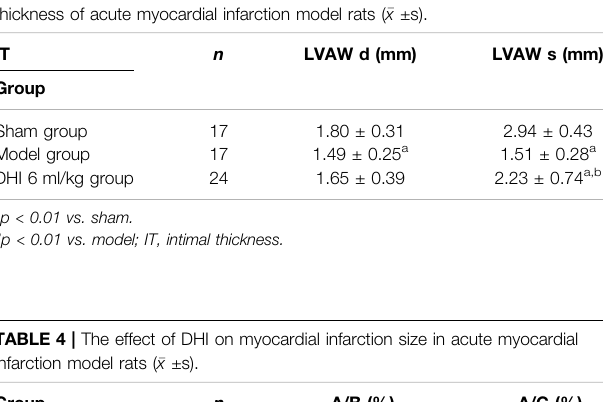
TABLE 4 | The effect of DHI on myocardial infarction size in acute myocardial infarction model rats ( (cid:1) x ±s). Group n A/B (%)